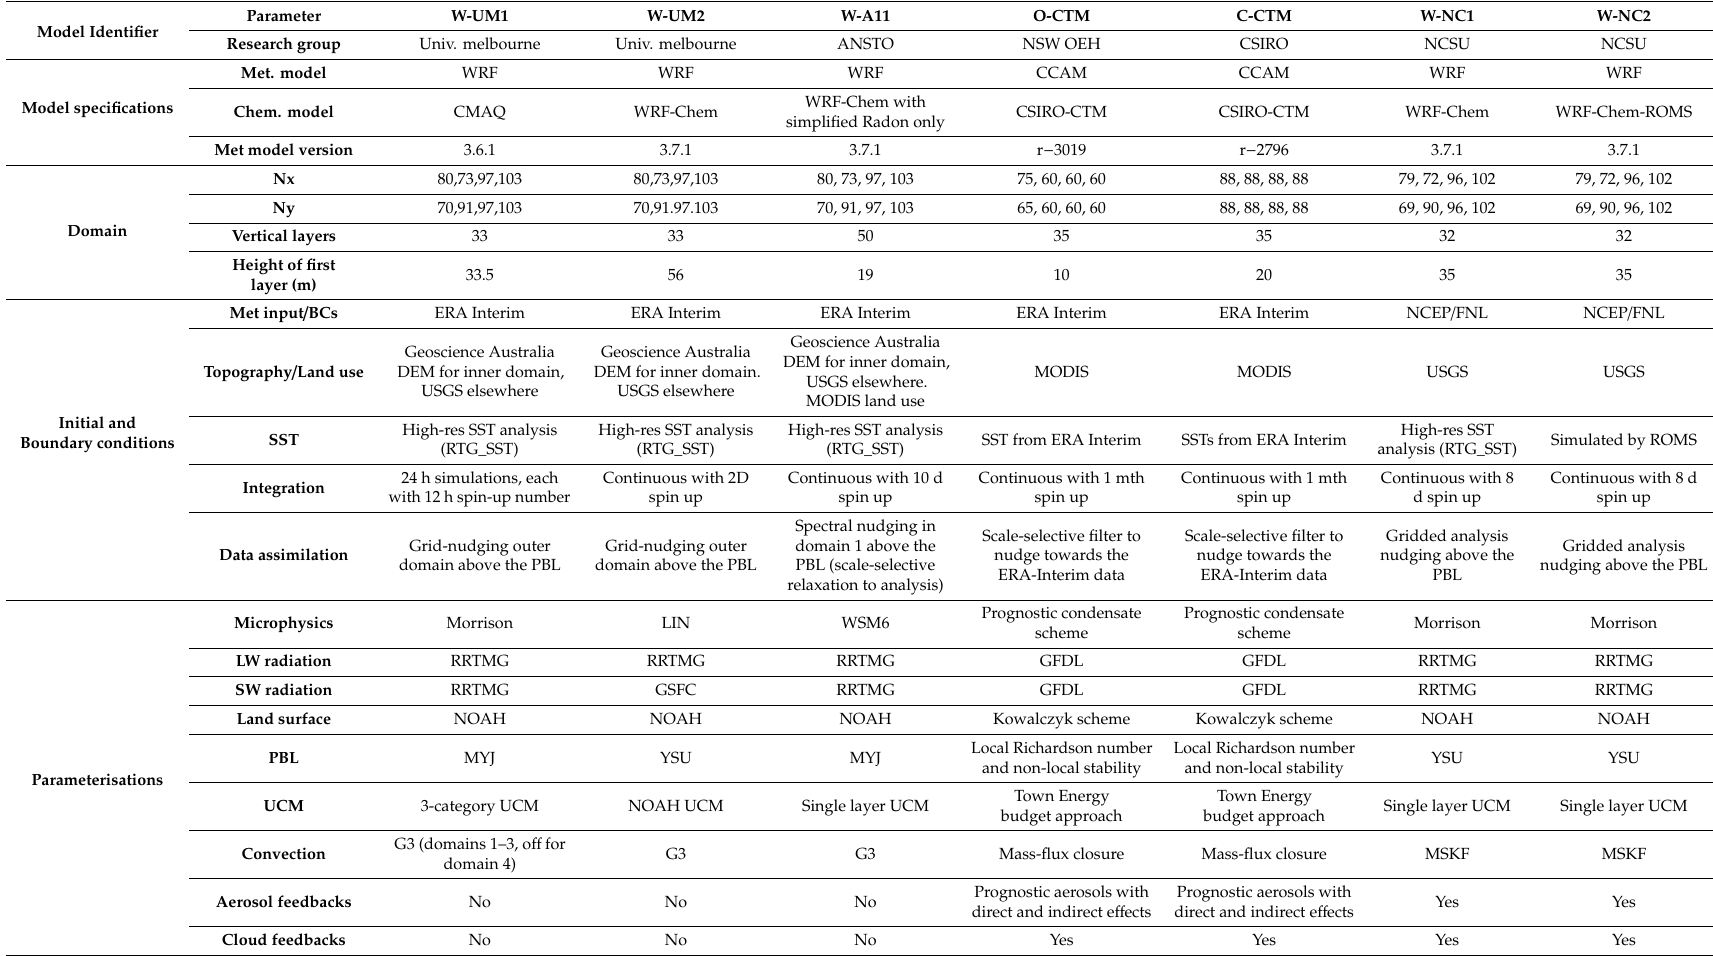
Table A1. Overview of the configuration of the meteorological models—reproduced from the companion paper “Evaluation of Regional Air Quality Models over Sydney and Australia: Part 1—Meteorological Model Comparison”